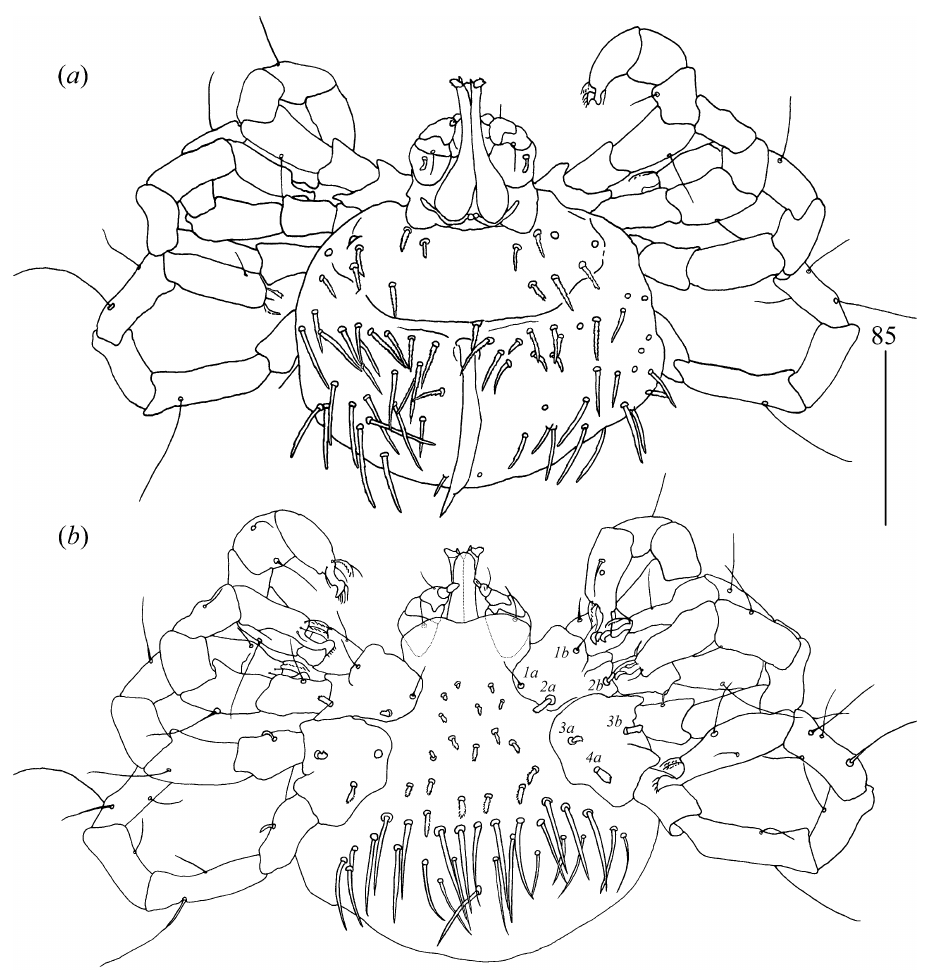
Figure 3. Geckobia gigantea sp. n., male: ( a ) in dorsal view; ( b ) in ventral view. Deutonymph (one paratype). Gnathosoma as in female. Chelicerae about 45 long. Swollen proximal part of chelicerae 20 long, slender distal part 25 long. Fixed cheliceral digit spinous, 5 long. Palpal tibia and tarsi with smooth setae. Each branch of peritremes 50 long. Idiosoma 150 long and 200 wide. Dorsum. Propodonotal shield 150 wide and 40 long, punctuate, with 16 plumose setae, 15–20 long. Dorsum covered by setae resembling that of propodonotal shield, about 15 long. Posterior and posteo-lateral setae serrate and 35–40 long. Venter with 20 pairs of short (about 15 long) plumose setae situated in anterior half of idiosoma and 13 pairs of longer (about 40 long) slightly serrate setae situated in posterior half of idiosoma as in Figure 4. Genital region (Figure 5a). Genital setae slightly serrate, setae g1 20 long, g2 and g3 about 10 long each. Pseudanal setae ps1–ps3 slightly serrate 30, 35 and 20 long, respectively. Additional unpaired seta ps4 on one side of idiosoma present. Legs . Coxal setation: 1a , 1b , 2a , 2b , 3a , 3b and 4a arranged in formula: 2–2–2–1. Coxal seta 1a and 1b filiform, 2a , 2b , 3a , 3b and 4a spur-like and serrate. All coxae punctate. Chaetotaxy of trochanters-tibiae I–IV as in female, except for lack of setae v (cid:48)(cid:48) TrIV . All setae of tibiae-trochanters I–IV filiform and smooth. Setation of tarsi I–IV as in